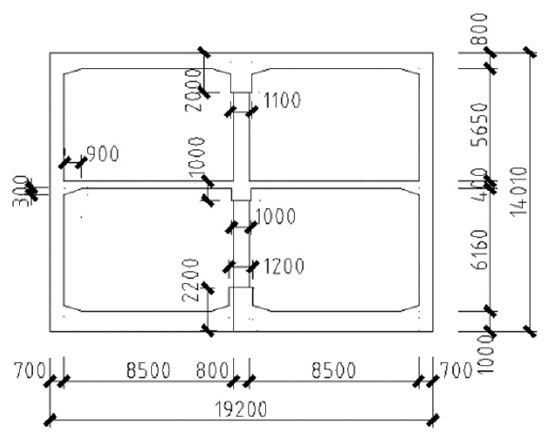
Figure 8. Schematic diagram of a typical cross section (dim.: mm). The station is located in Chang’an district of Xi’an city. The site type in this area is class II, the basic seismic intensity is 8 degrees, and the characteristic period of seismic response spectrum is 0.4 s. The seismic parameters of station engineering are displayed in Table 2. Table 2. Ground motion